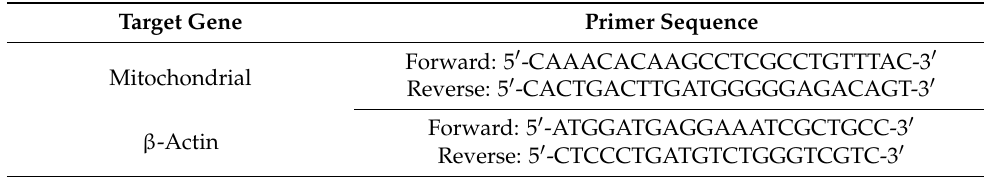
Table 1. Primers used for real-time quantitative